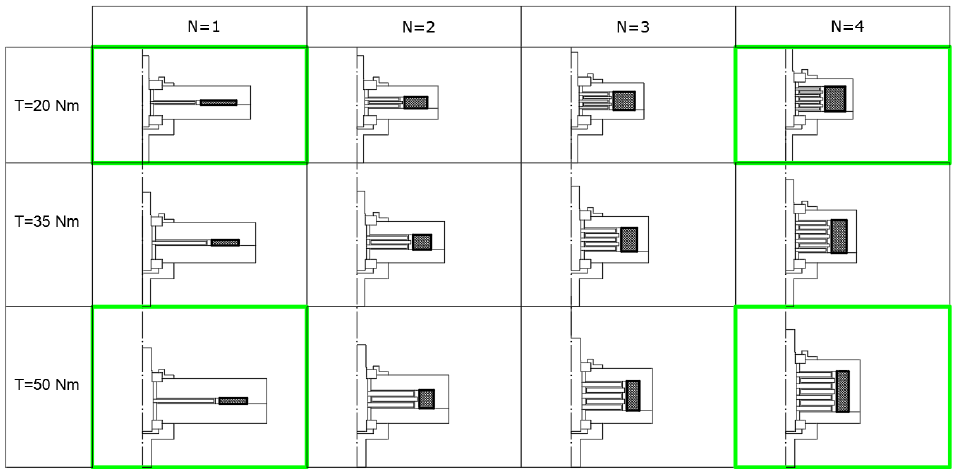
Figure 10. Graphical overview of cross-sections for the 12 designed variants: T c = 20 Nm, N = 1,2,3,4, T c = 35 Nm, N = 1,2,3,4 and T c = 50 Nm, N =